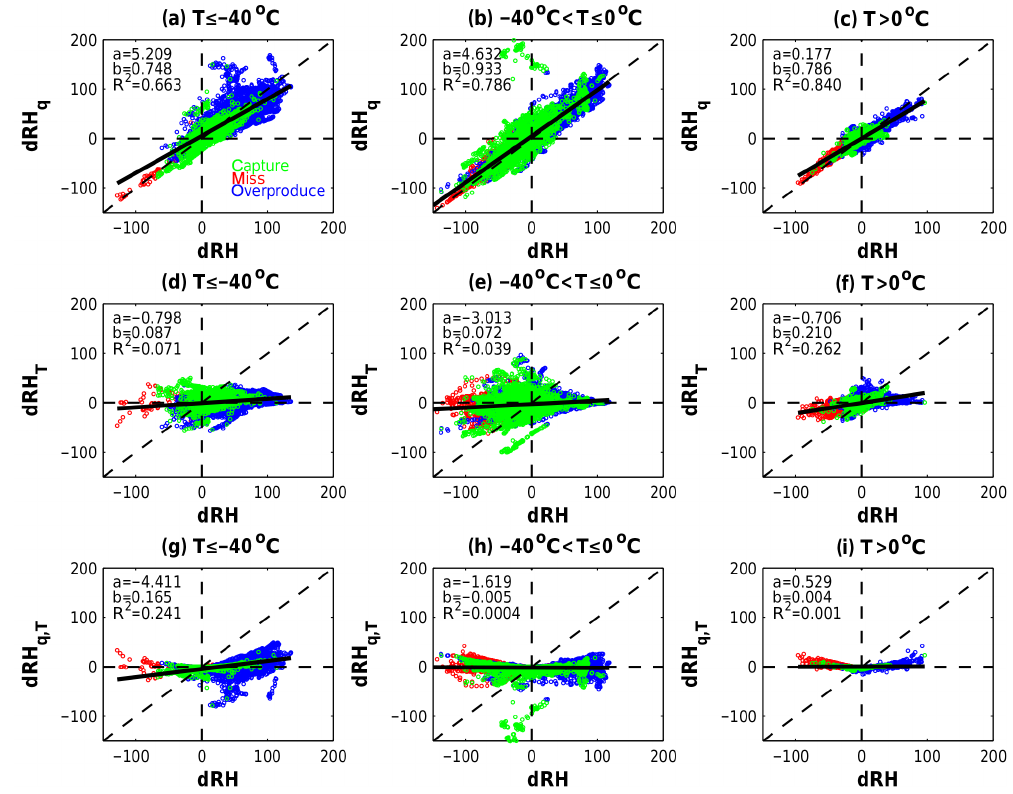
Figure 4. Corresponding (top) d RH q versus d RH, (middle) d RH T versus d RH, and (bottom) d RH q,T versus d RH (unit: %) for different temperature ranges. The colors indicate three types of model performances in simulating clouds as described in Fig. 2: green (“captured”), red (“missed”), and blue (“overproduced”). The black lines denote the linear regressions of the samples (i.e., Y = a + b × X) , and the intercept (i.e., a ) and slope (i.e., b ) of the regression lines as well as the coefficient of determination (i.e., R 2 ) are shown in the